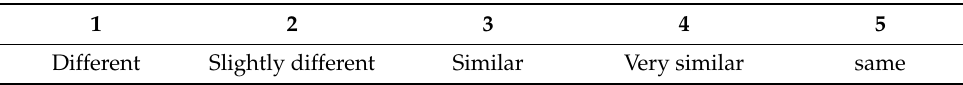
Different Slightly different